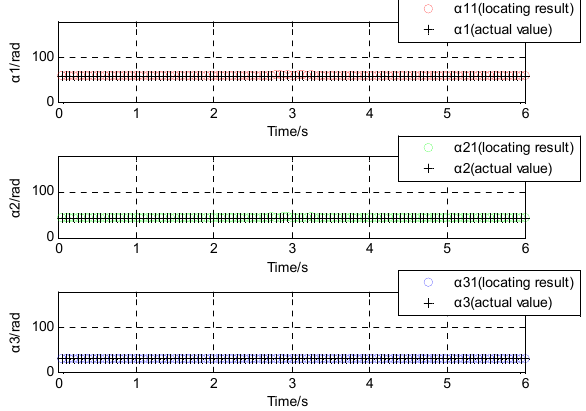
Figure 9. The rotation angle of the moving ferromagnetic target considering angular rotation.